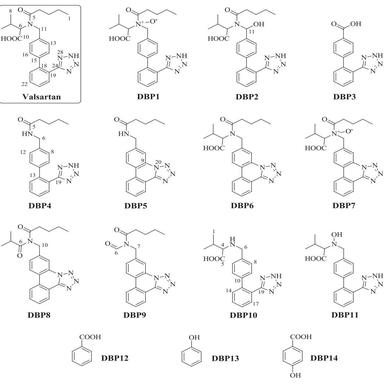
Chemical structures of Valsartan and its degradation byproducts DBP1–DBP14.